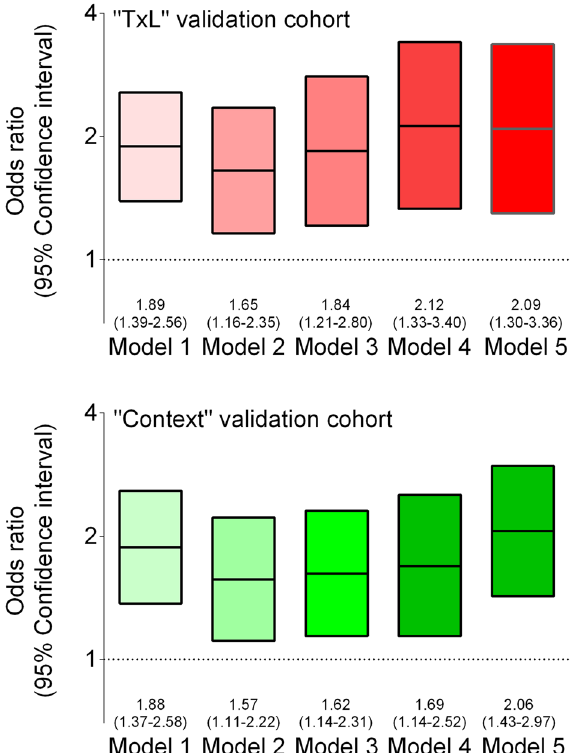
Figure 1. Risk of delayed graft function in the two independent validation cohorts, “TxL” and “CONTEXT”. The graphs show the odds ratios and 95% confidence intervals using logistic regression to characterize the association between continuous pretransplant plasma endotrophin per increase in standard deviation and delayed graft function. Model 1 was unadjusted. Model 2 was adjusted for age, sex, race, and dialysis vintage (months). Model 3 was further cumulative adjusted for blood pressure and transplant type. Model 4 was further cumulative adjusted for pretransplant plasma creatinine. Model 5 was further cumulative adjusted for